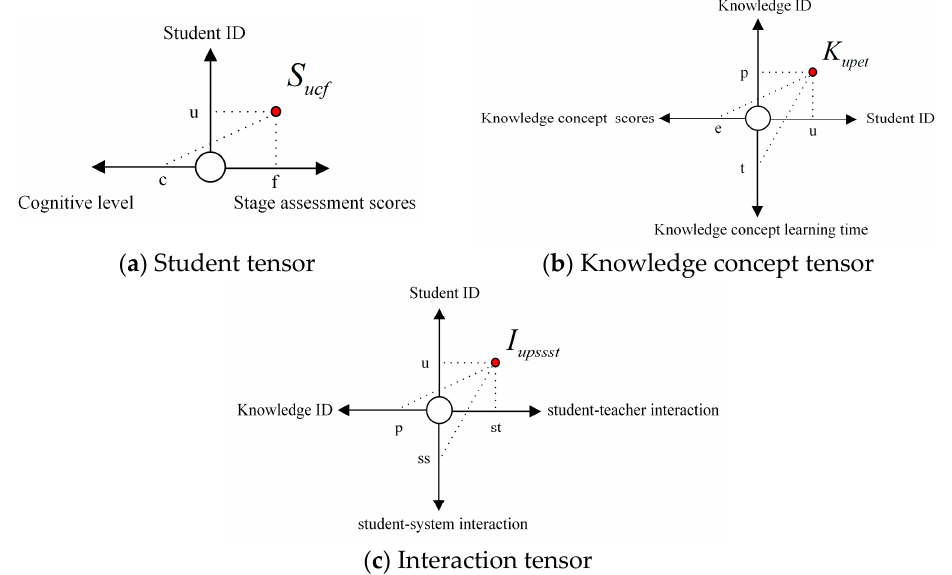
Figure 1. Construction of the Base Tensor.